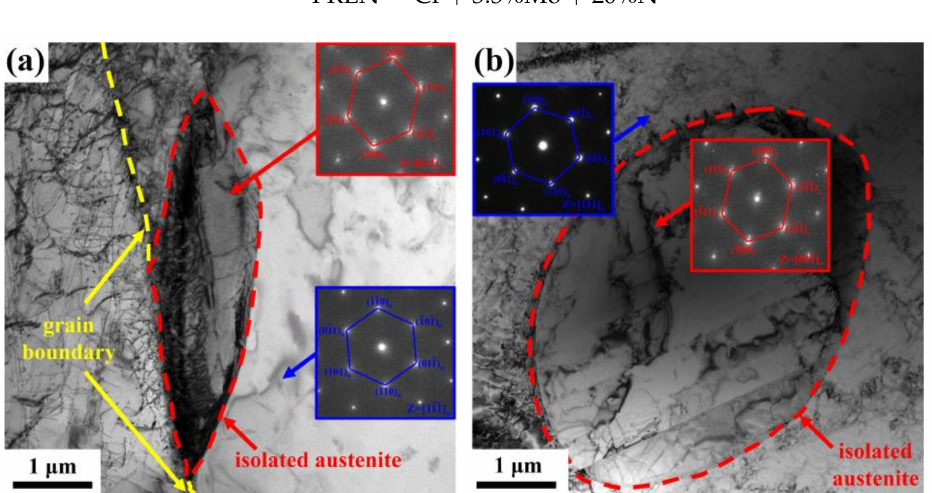
Figure 2. TEM morphologies of the Isolated austenite precipitated at α / γ boundary ( a ) and interior α ( b ).